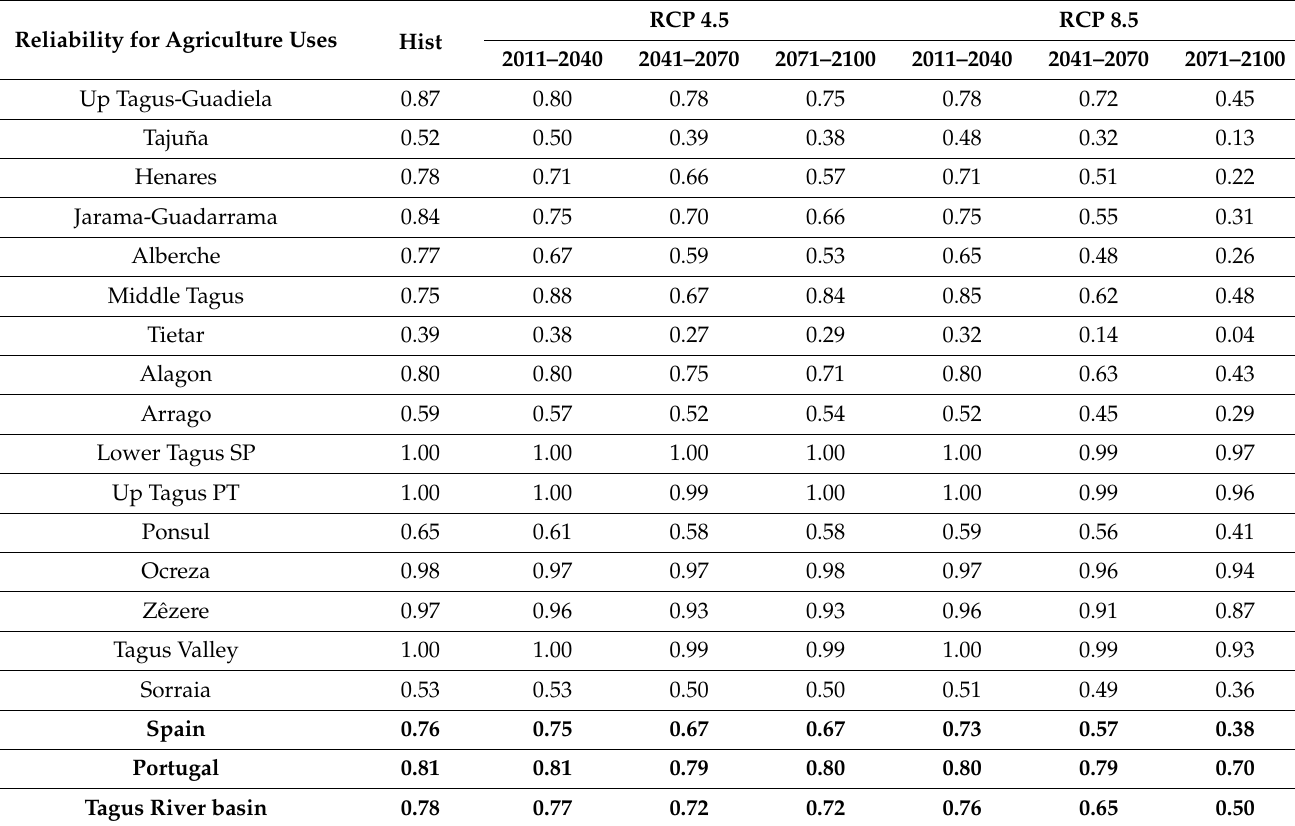
Table 2. Reliability of agricultural supply under future scenarios.